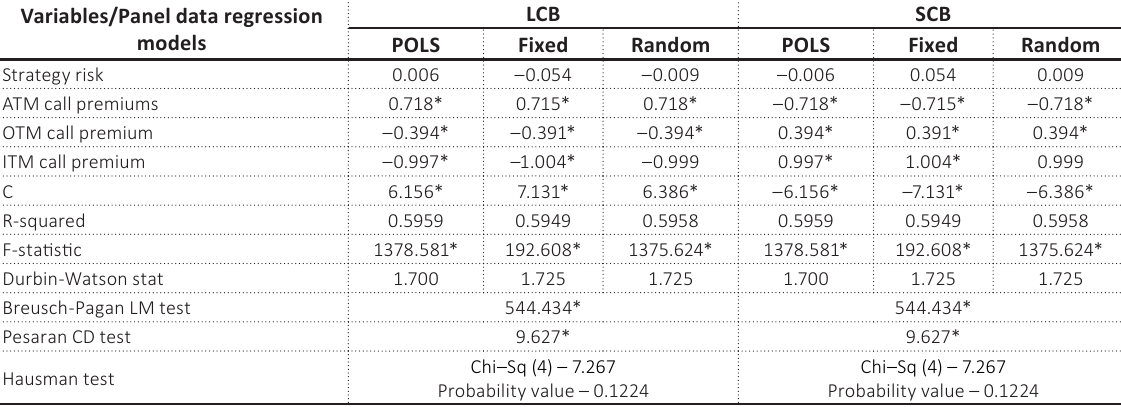
Table 3. Panel regression analysis for LCB and SCB strategies Variables/Panel data